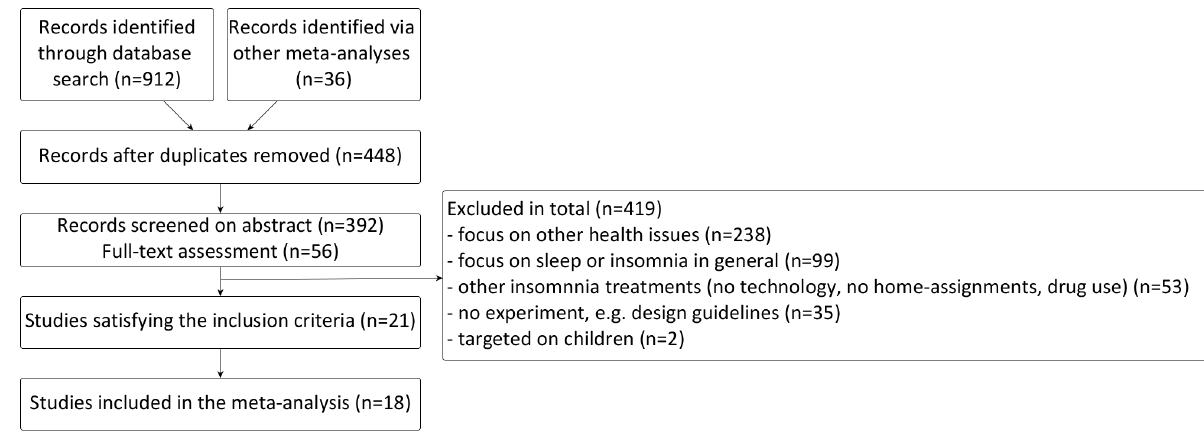
Figure 1. Inclusion and exclusion criteria for papers in the